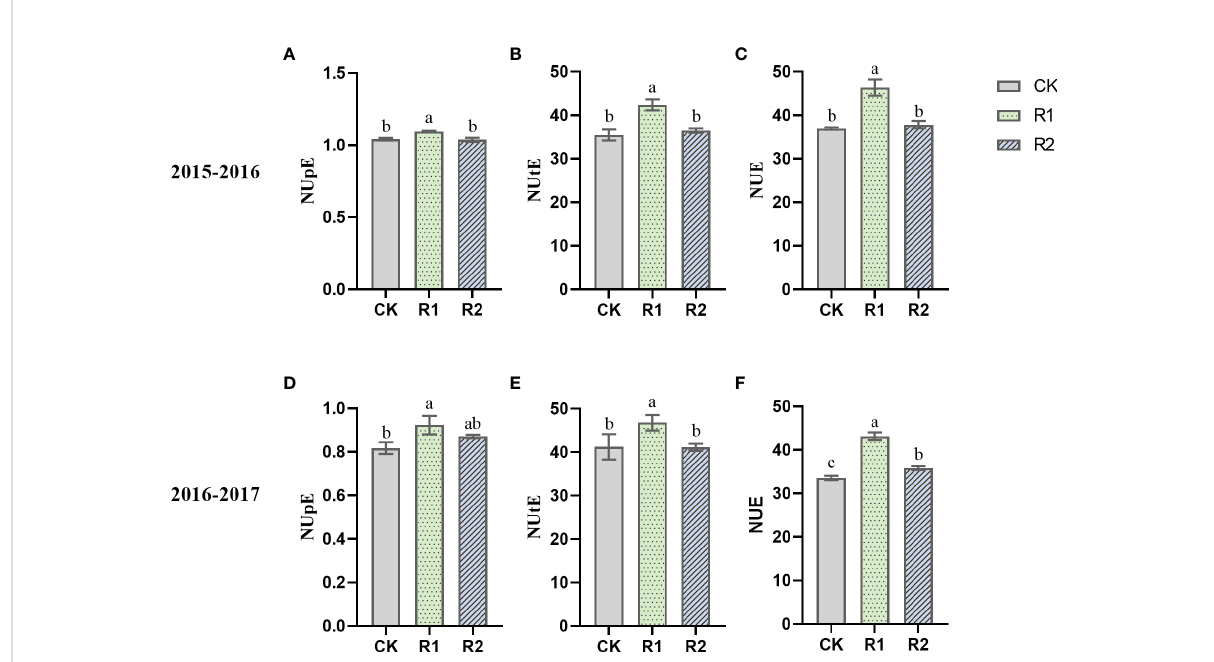
FIGURE 3 Nitrogen uptake ef fi ciency (NUpE) (A, D) , Nitrogen utilization ef fi ciency (NUtE) (B, E) and nitrogen use ef fi ciency (NUE) (C, F) under different treatments in 2016 – 2017. CK, uniform planting (20 cm); R1, wide-narrow row planting (12 cm-12 cm-12 cm-24 cm); R2, narrow uniform planting (12 cm). Different letters indicate signi fi cant differences among row spacing mode in the speci fi c year at the P < 0.05 level.